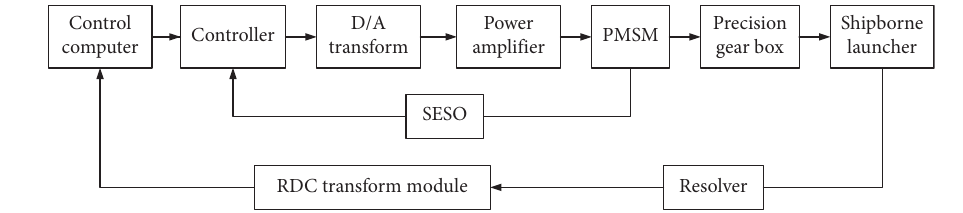
Figure 1: Structure of the rocket launcher servo system.